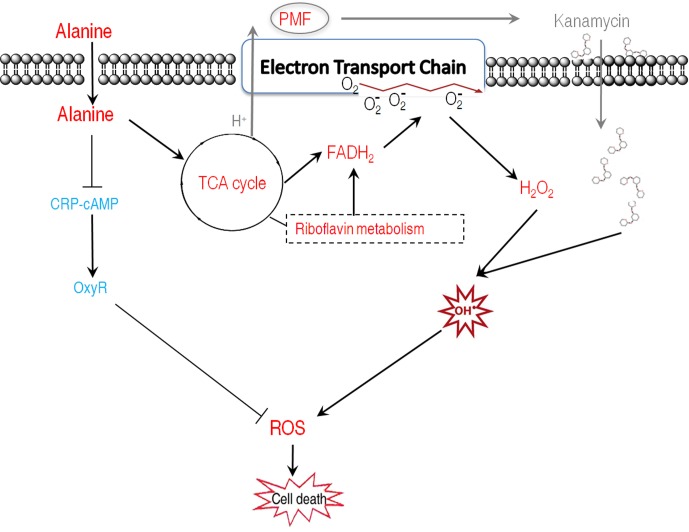
Proposed model for the dual roles of alanine in facilitating kanamycin to kill antibiotic-resistant bacteria. Exogenous alanine facilitates kanamycin to kill antibiotic-resistant bacteria through increased kanamycin uptake, and enhanced ROS production. Meanwhile, alanine decreased the transcription of oxyR, which plays essential role in positively regulating antioxidant enzymes. Thus, the enhanced ROS production was achieved through FADH2 oxidation and repression of antioxidant function genes via OxyR in an unidentified manner. Red represents increase and blue represents decrease.